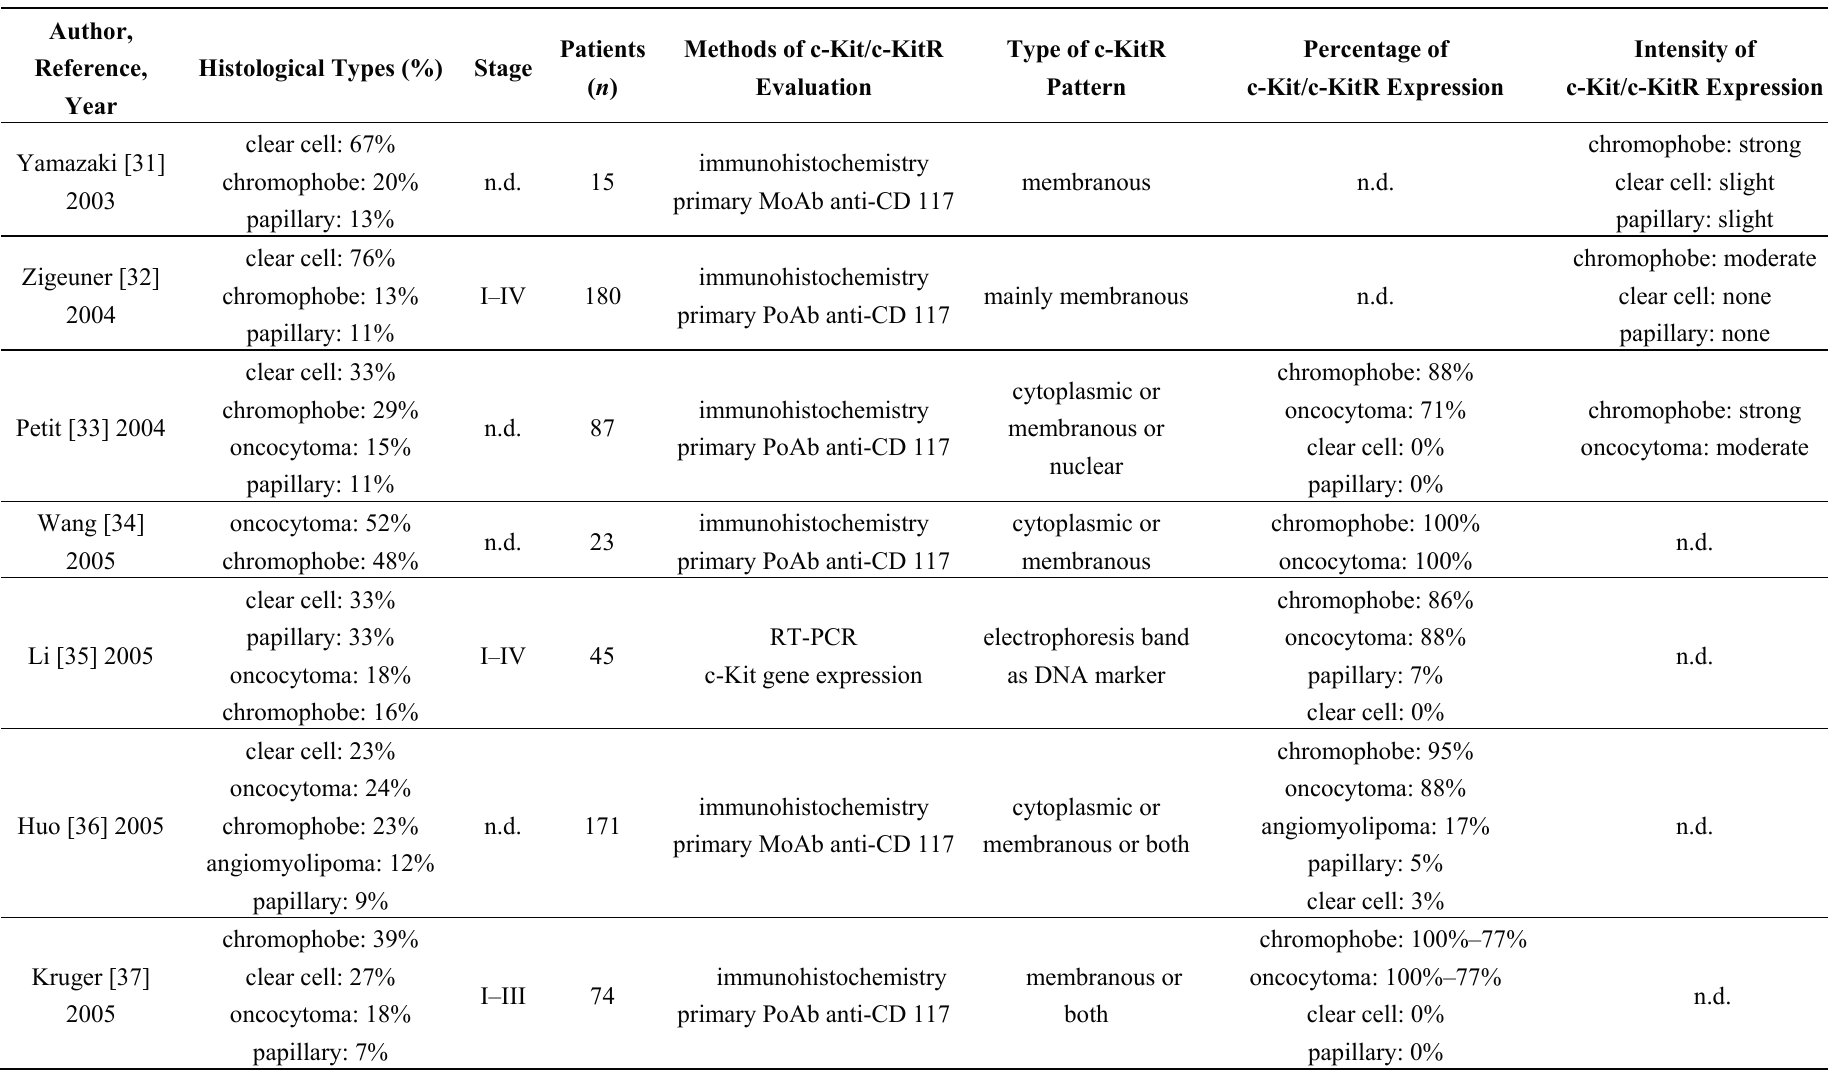
Table 1. Principal studies evaluating c-Kit/c-KitR expression in renal cancer